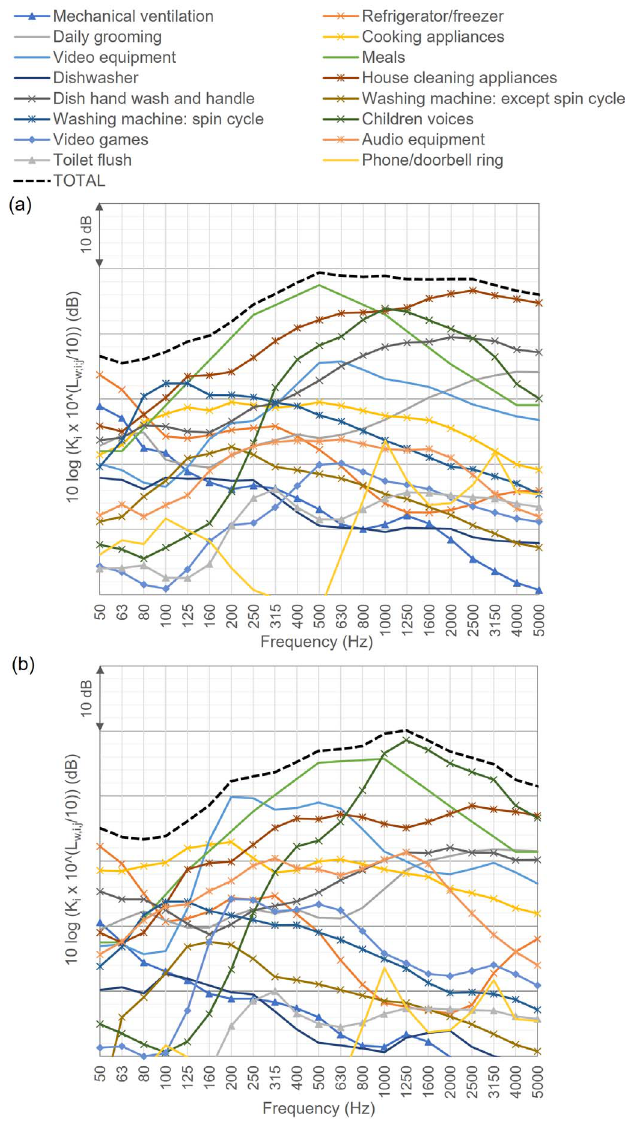
Figure 1. Alternative indoor sound spectrum derived from (a) the AVG spectra and (b) the MAX spectra, of the considered sound source categories.